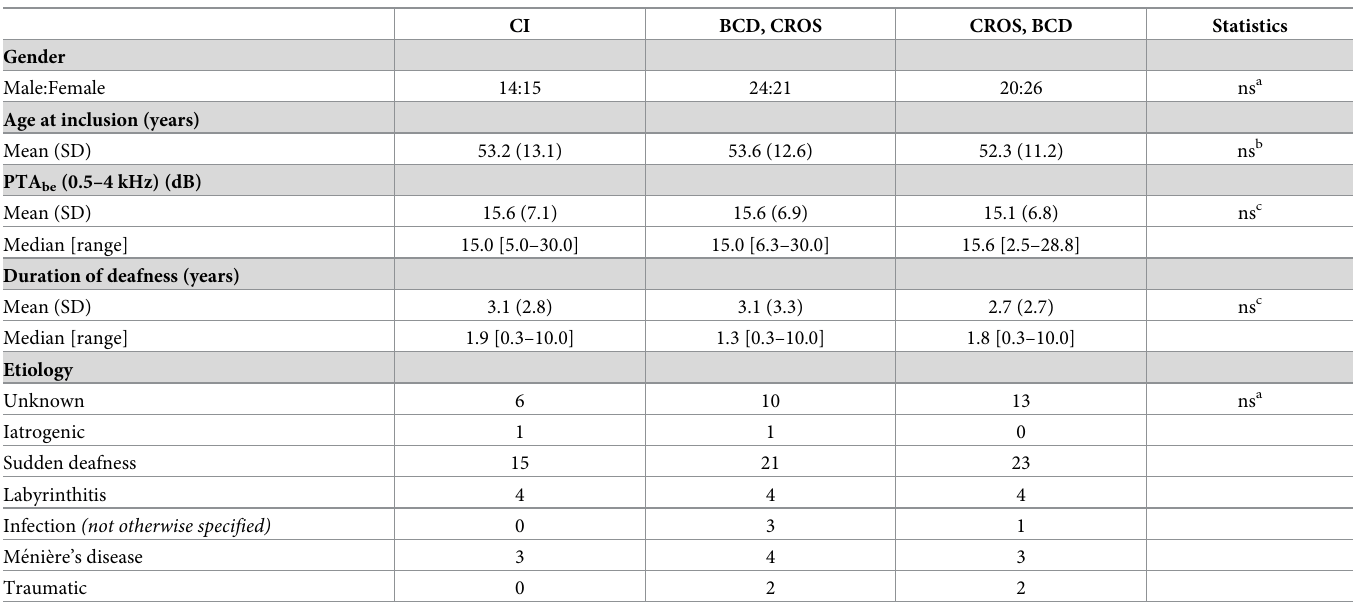
Table 1. Patient characteristics per group after